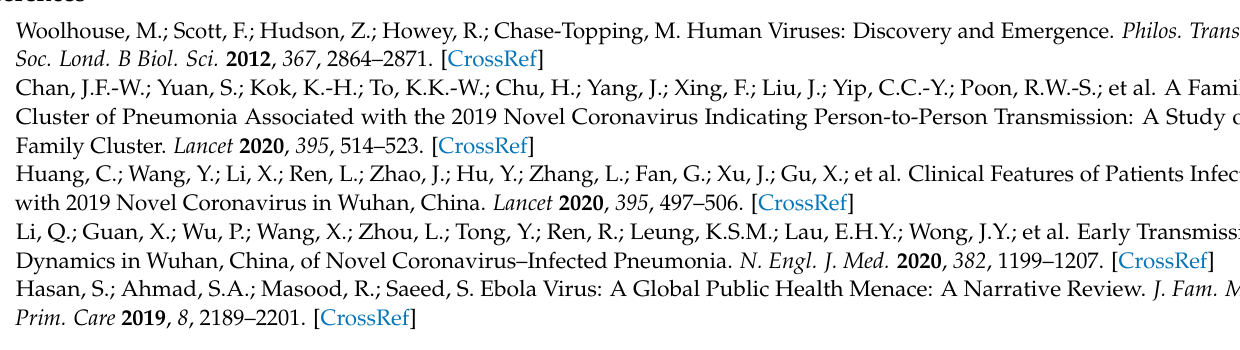
Drugbank. Table S2: Supplementary information for Table 3. Table S3: Pockdrug druggability prediction